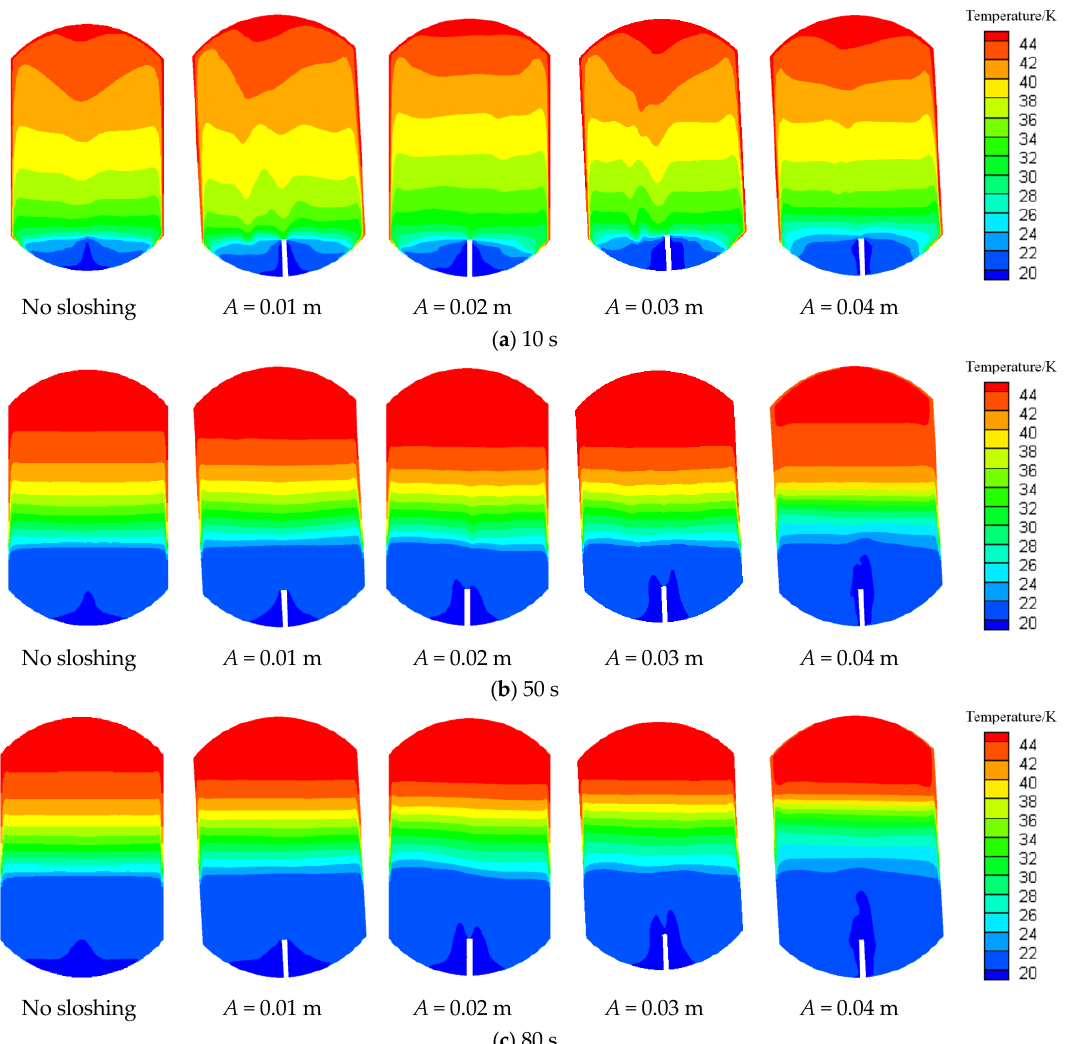
Figure 14. Graphic contours of temperature distribution under different sloshing amplitudes ( f = 3 Hz) at ( a ) 10 s, ( b ) 50 s, and ( c ) 80 s.